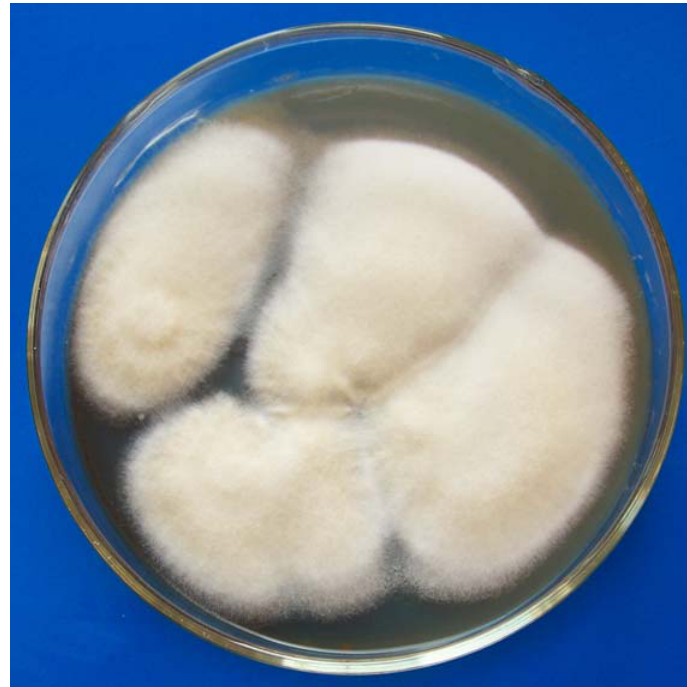
Figure 2. Picture of Penicillium